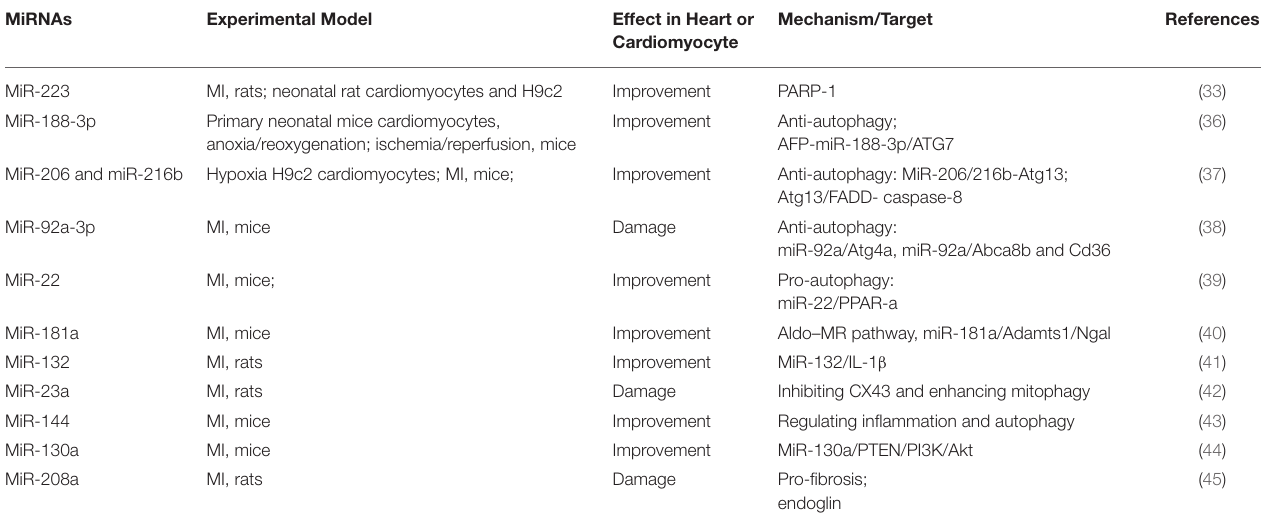
TABLE 2 | Summary of studies on miRNA regulating MI by autophagy in the past 5 years.